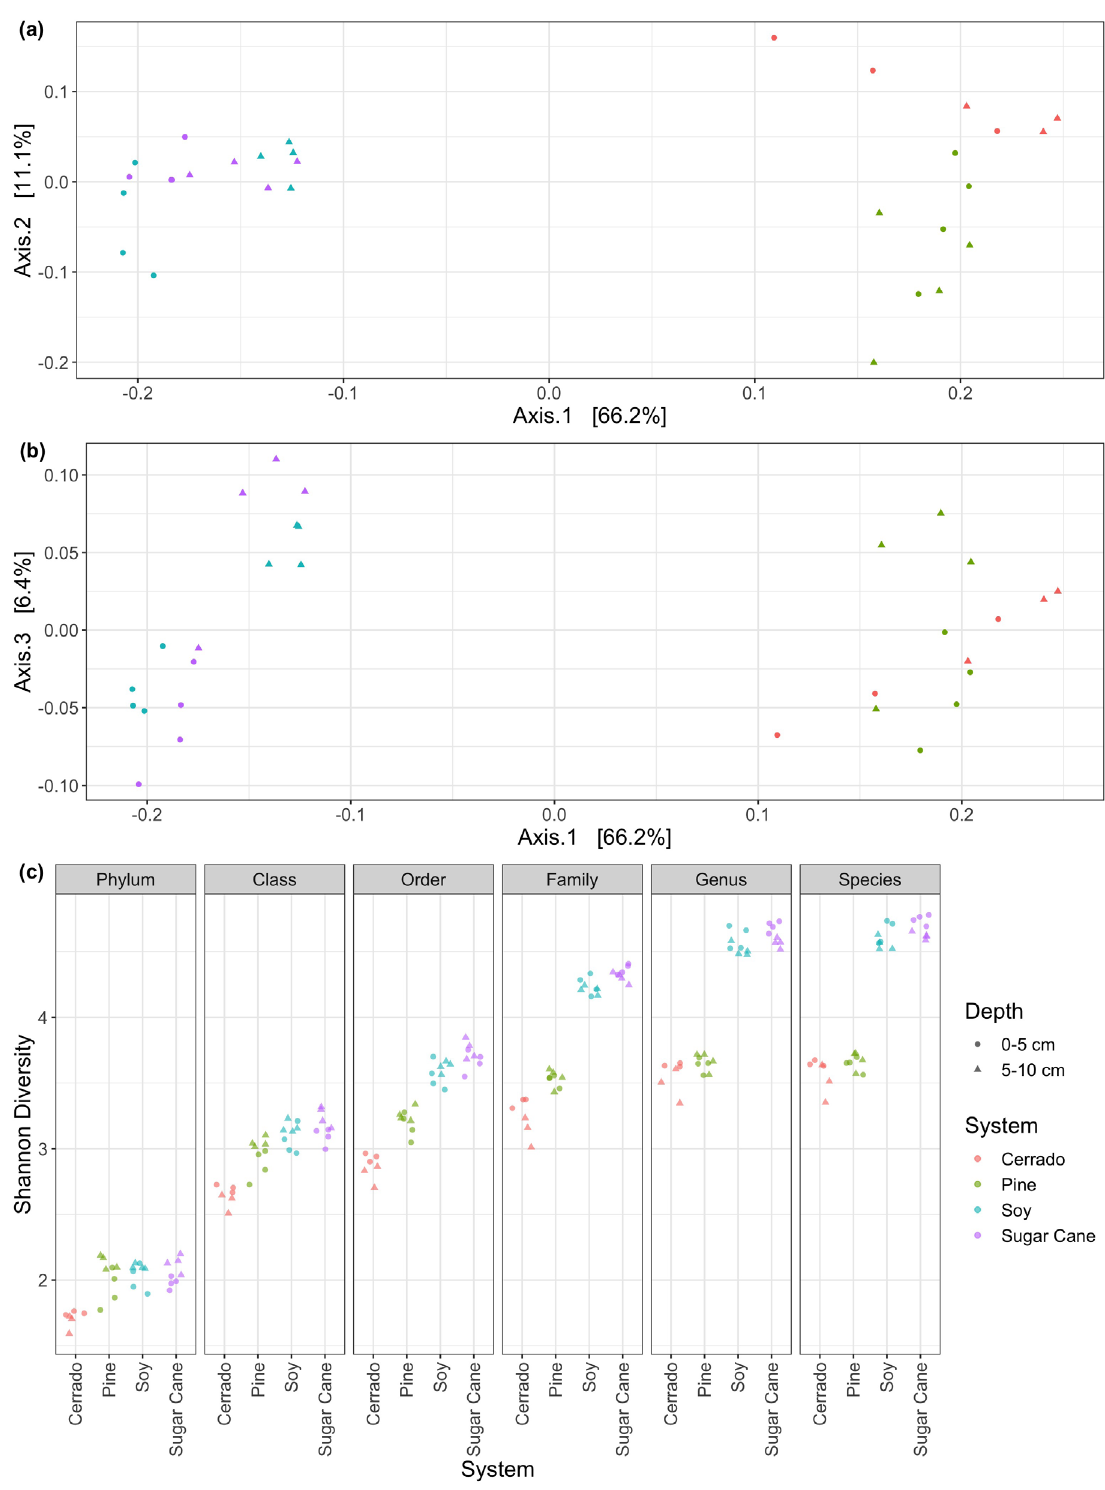
Figure 5 Weighted UniFrac distances ( a and b ) and Shannon diversity indexes ( c ) in land use ecosystems and two depths. The analysis of diversity was performed of high-throughput sequencing of 16S rDNA gene at 97% similarly